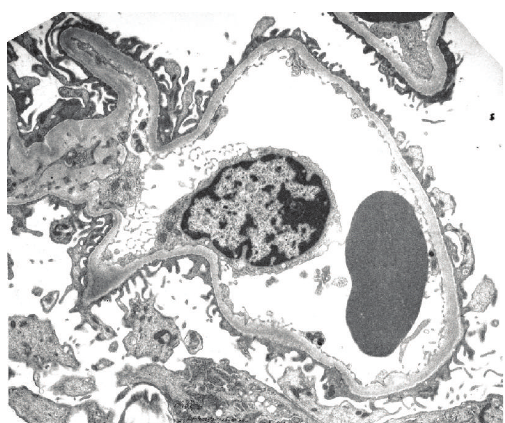
Figure 2: Fenestrated endothelium, intact glomerular basement membranes, and infrequent podocyte foot process e ff acement (transmission electron microscopy, original magnification